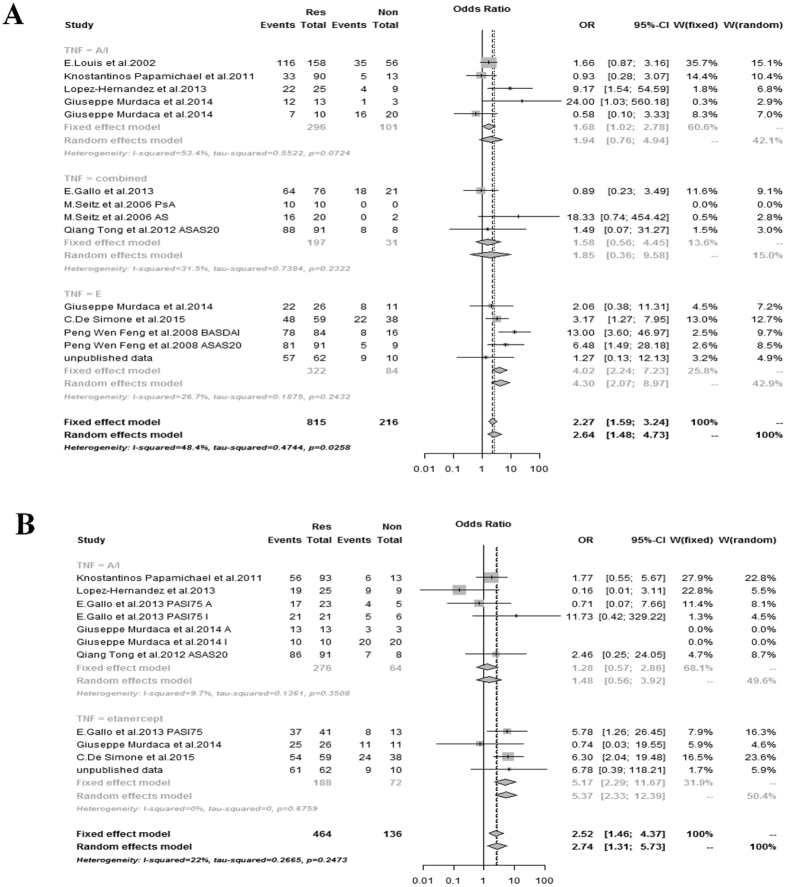
Odds ratios (ORs) and 95% confidence intervals (CI) from each study testing association of (A) −308 G > A TNFα polymorphism and (B) −238 G > A to the response to TNF blockers in different TNF blockers in SpA patients.If p-value < 0.1 we used the result of random effects model. Otherwise, a fixed effect model was used. A/I: adalimumab/infliximab, events: number of subjects with the common allele (G) observed, Res: responder, Non: nonresponder.